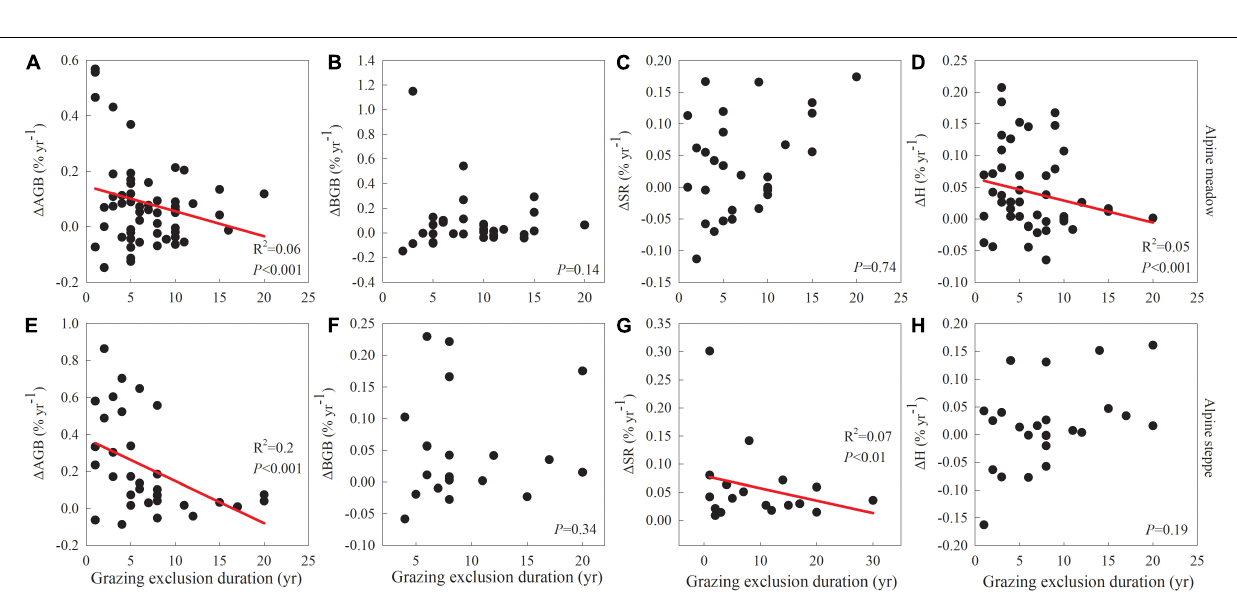
FIGURE 3 | Relationships of the percentage of mean annual changes in above- and belowground biomass, species richness, and Shannon-Wiener index with grazing exclusion duration in alpine meadows (A–D) and alpine steppes (E–H) . AGB, BGB, SR, and H represent aboveground biomass, belowground biomass, species richness and Shannon-Wiener index,